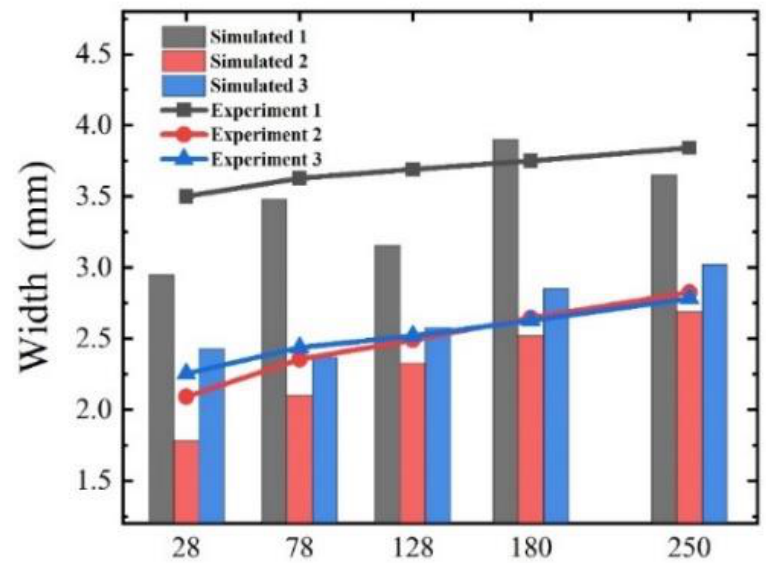
Figure 6. Comparisons of simulated and experimental weld widths.